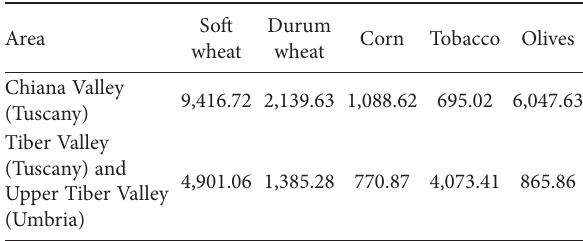
Table A2.1. Total crop acreage in the municipalities of the Chiana Valley and Tiber/Upper Tiber Valley included in the study.